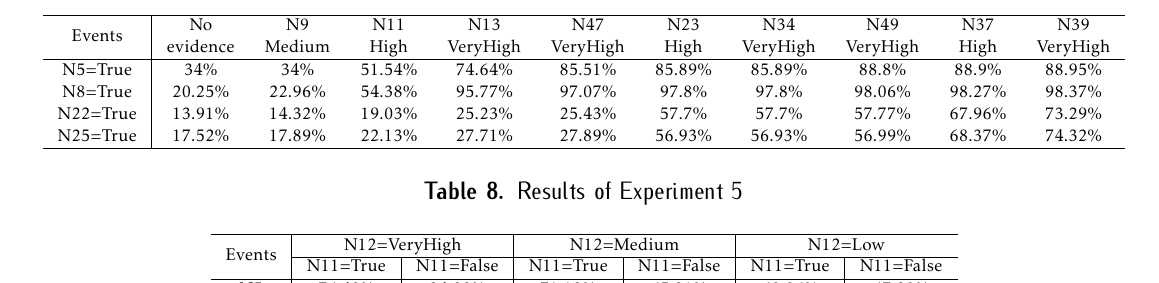
Table 7. Results of Experiment 4